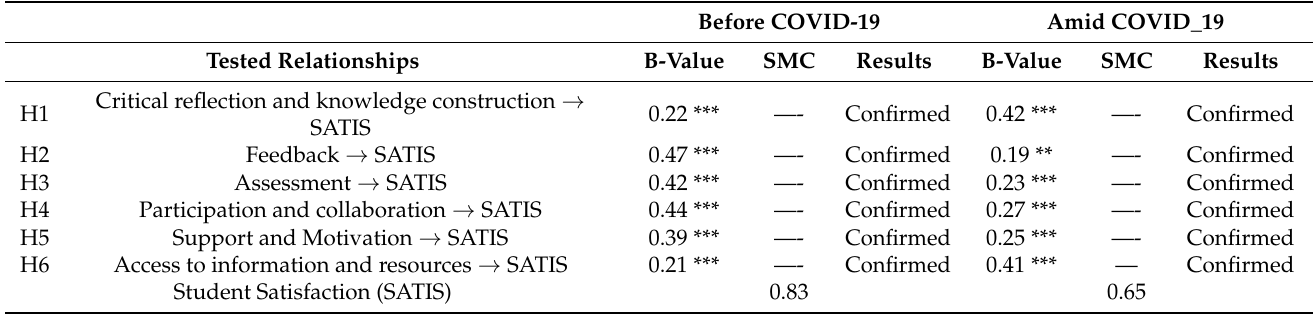
Table 3. Hypotheses results for the two comparative models (before and amid COVID-19 models).